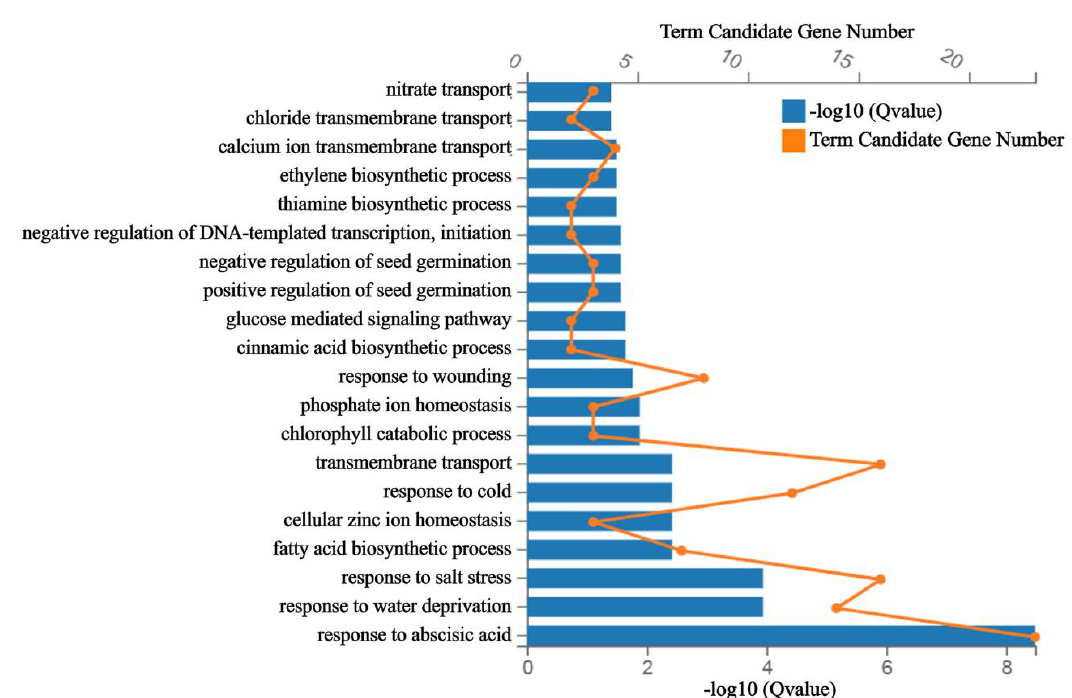
Figure 6. Functional categorization of the differentially expressed genes. Function categorization of the DEGs down-regulated in ABA + DEX treated 35S:AtbZIP62-GR transgenic plant seedlings. DEGs down-regulated in ABA + DEX treated 35S:AtbZIP62-GR transgenic plant seedlings were subject to Gene Ontology (GO) biological enrichment by using the pHyper function in R software and estimated by hypergeometric test. Adjusted p -values ( − log10 or Q-values) depicting significant enrichment (q-value <